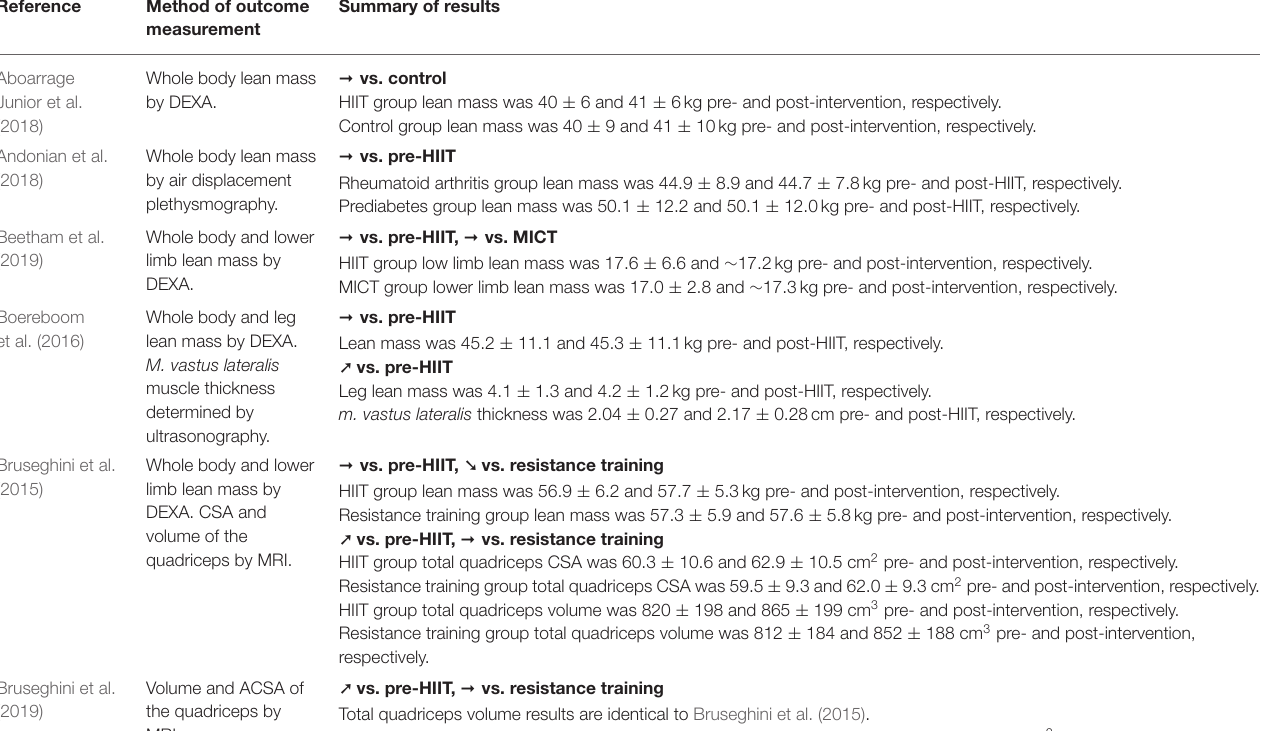
TABLE 3 | Summary of study details concerning HIIT and muscle quantity or quality. Reference Method of outcome Summary of measurement